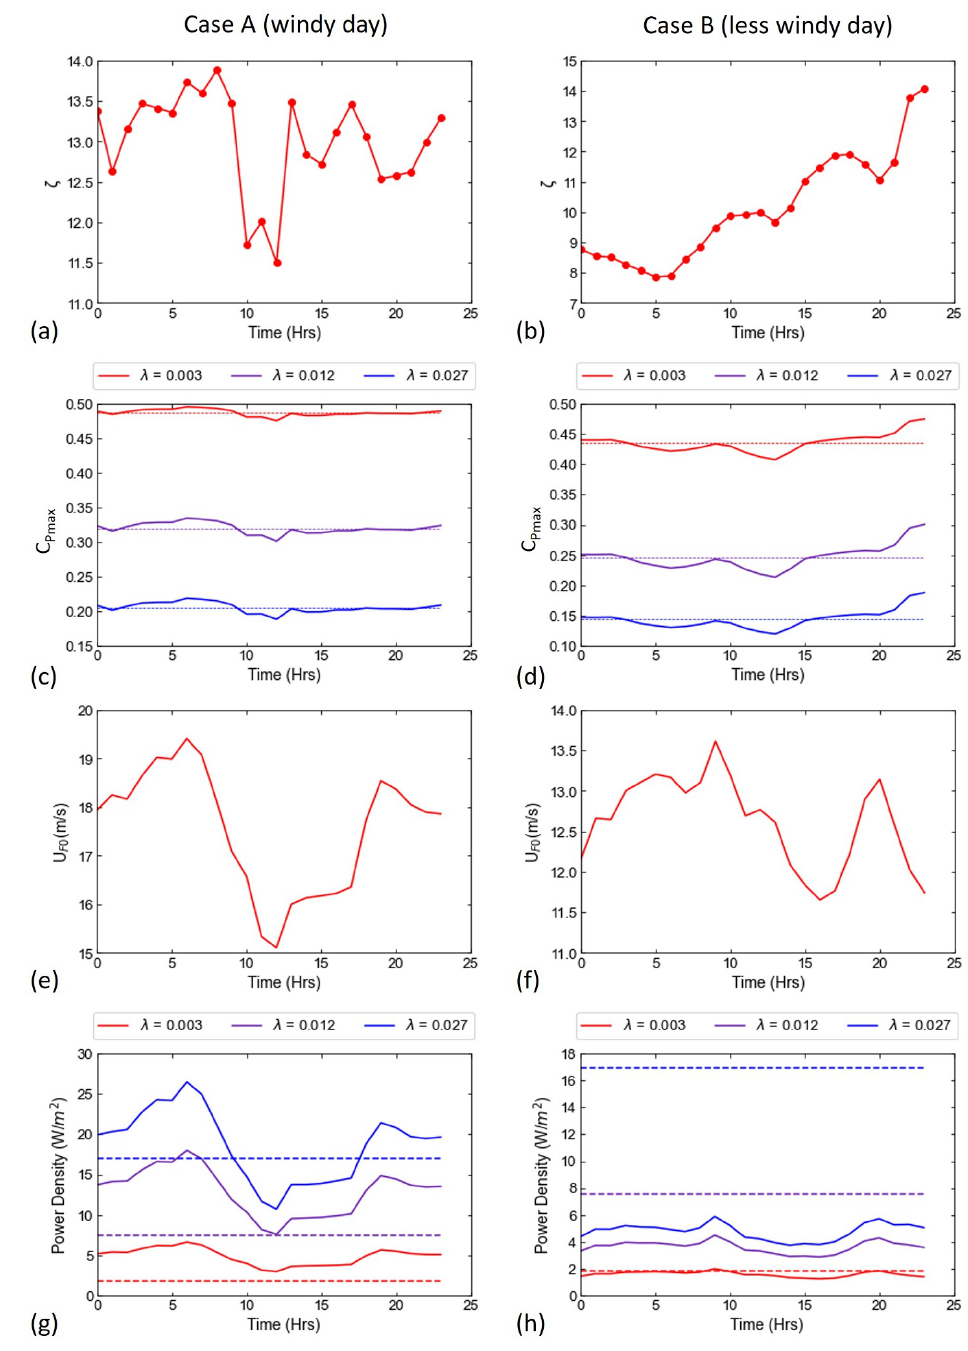
Figure 9. Time-histories of site-specific atmospheric conditions and how they affect the maximum performance of large wind farms (over the 24 h of two separate days): ( a , b ) momentum response parameter ζ ( c , d ) maximum power coefficient C P max of ideal turbines with three different array densities (with 24 h average values shown by dotted lines) ( e , f ) undisturbed farm-average wind speed U F 0 ( g , h ) maximum power density achieved by ideal turbines with three different array densities (with ‘rated’ power density values shown by dashed